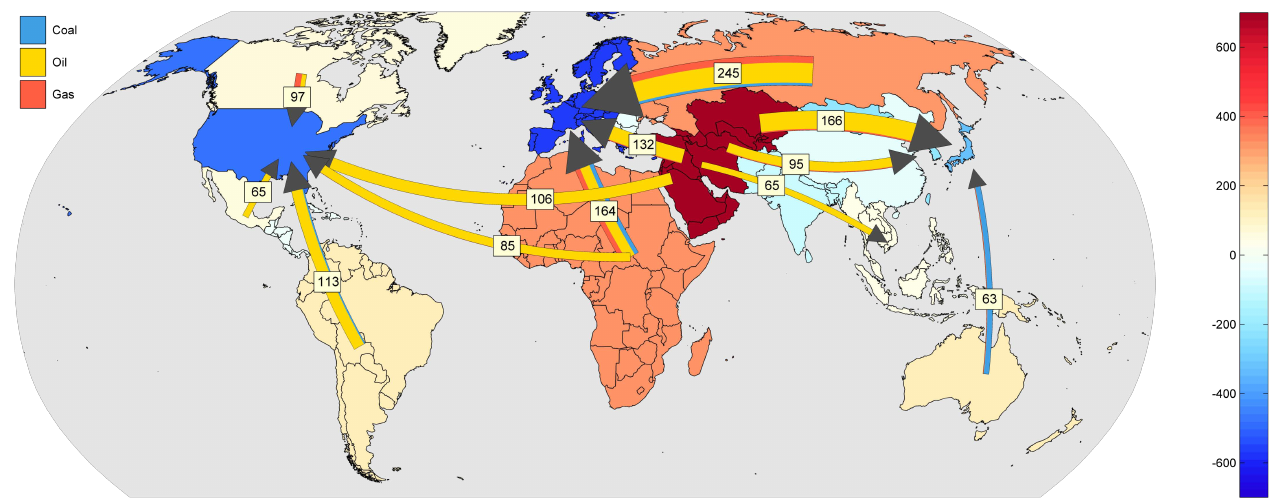
Fig. 9. The top 12 inter-regional flows of fossil fuel carbon embodied in trade from extracting region to producing region, broken down by primary fuel type, and disaggregated further to highlight key countries (2004). With Japan and China separated, the largest single inter- regional flow is from Russia to Europe (245MtC), primarily oil and gas. This grouping also highlights that most of the emissions imports to North America are in fact to USA. Table 9. The 2004 fossil fuel carbon used as feedstock in each region (production), the amount and share exported, the consumption of feedstock for products (consumption) amount and share imported, and the difference between production and consumption (and exports and imports). Exports and imports only represent the trade between the RECCAP regions, and do not include the trade between countries within a region (e.g. Finland and Sweden). The shares are always in terms of production. Production Consumption Balance Region Production Exports Share Consumption Imports Share Balance